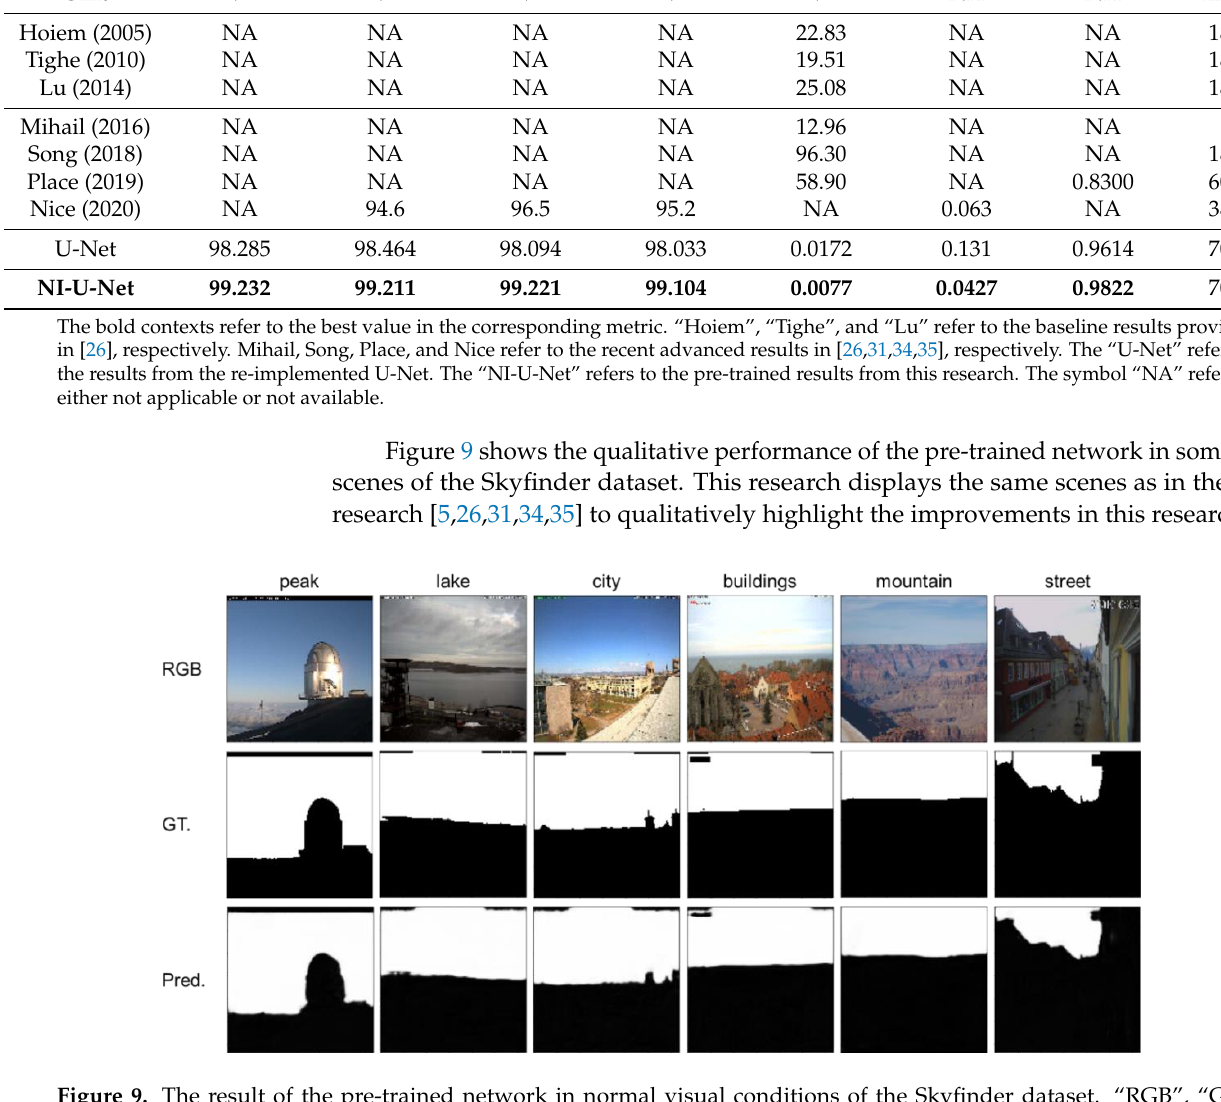
Table 2. The pre-trained sky and ground segmentation network results evaluated in the open benchmark (the Skyfinder dataset). Metrics